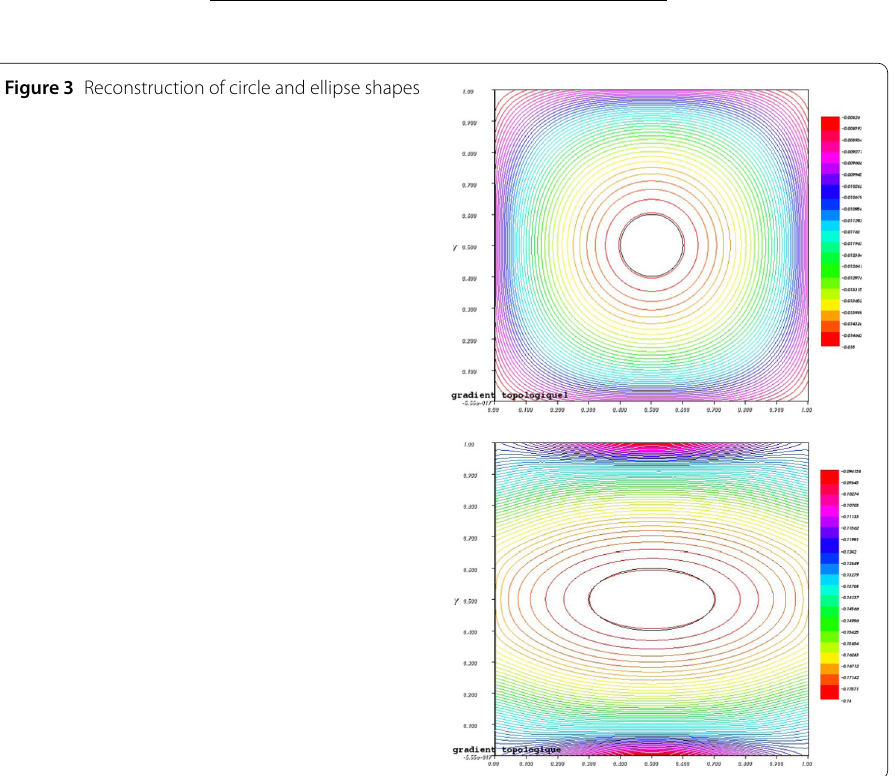
Figure 3 Reconstruction of circle and ellipse